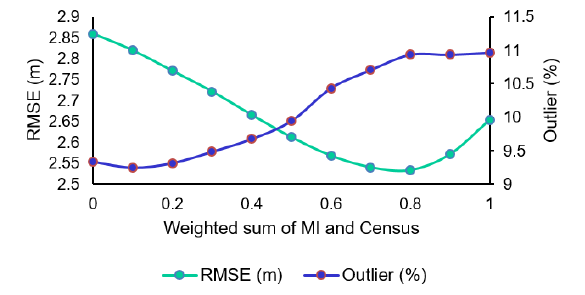
Figure 2. The Height residual (im meter) of the point cloud gen- erated by SGM and the weighted sum cost